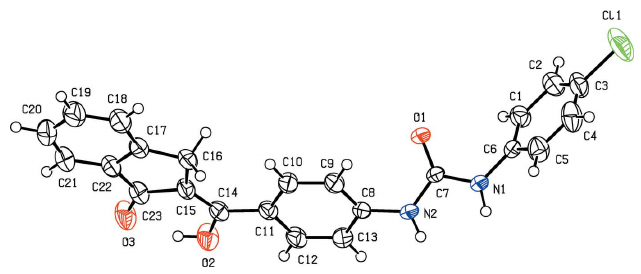
Figure 1 The molecular structure of the title compound, showing displacement ellipsoids drawn at the 50% probability